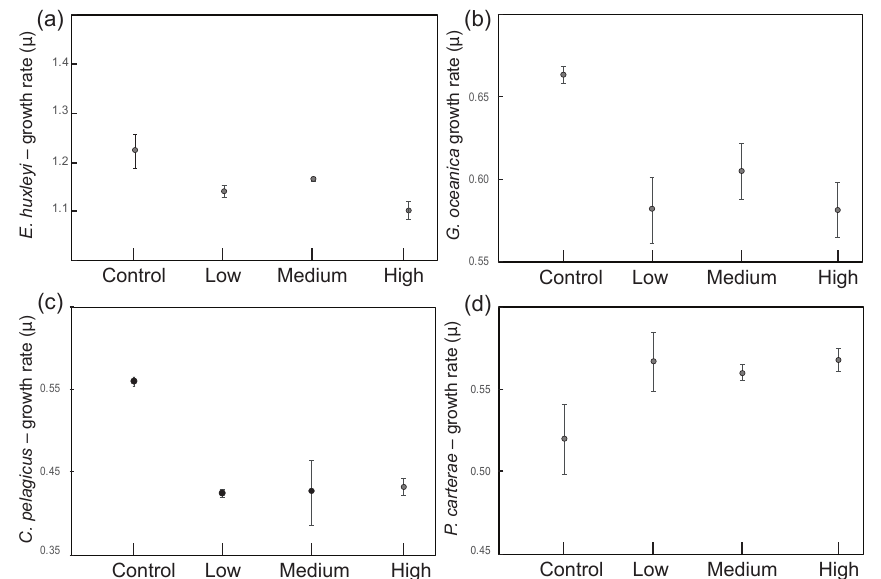
Figure 3. Average growth rate; all measurements are done in triplicates; error bars denote standard deviation. If not visible, error bars are smaller than symbols. (a) E. huxleyi; (b) G. oceanica ; (c) C. pelagicus ; (d) P. carterae. Note the different scales on the y axis.